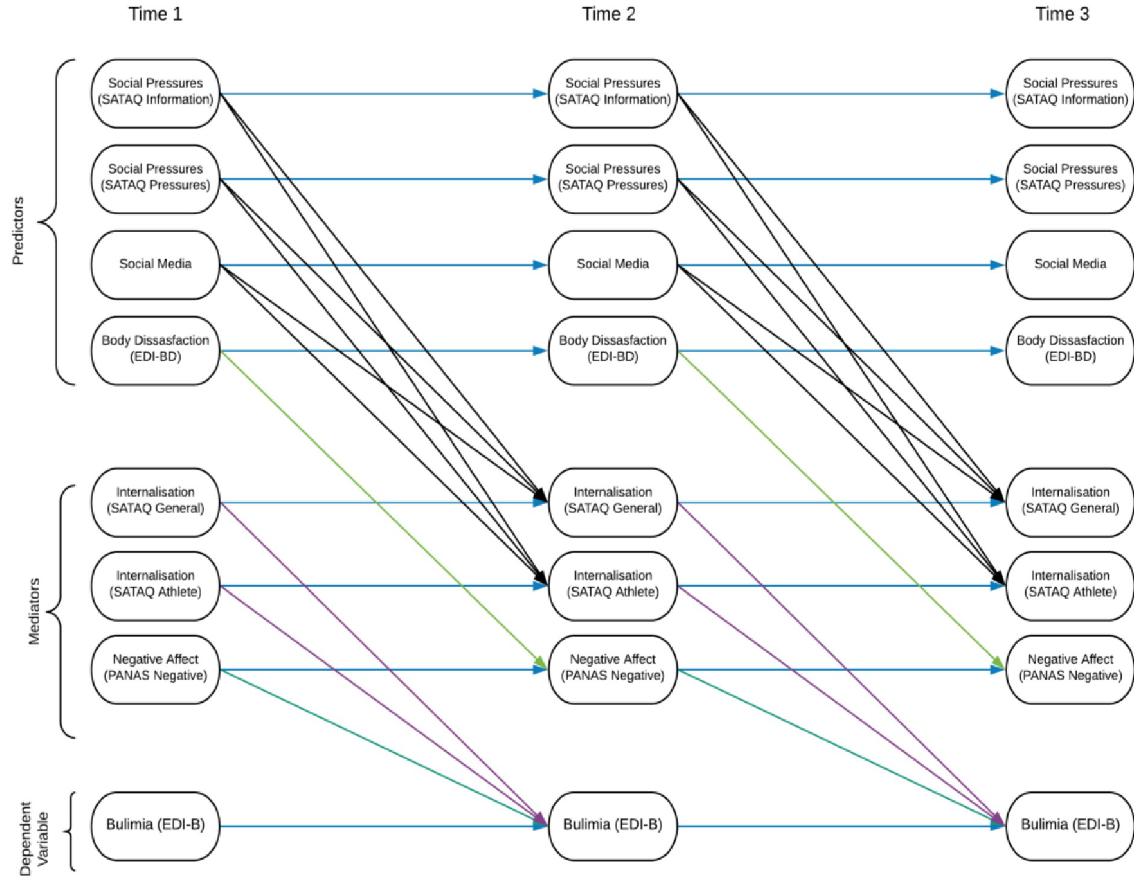
Fig 2. Cross-lag mediation